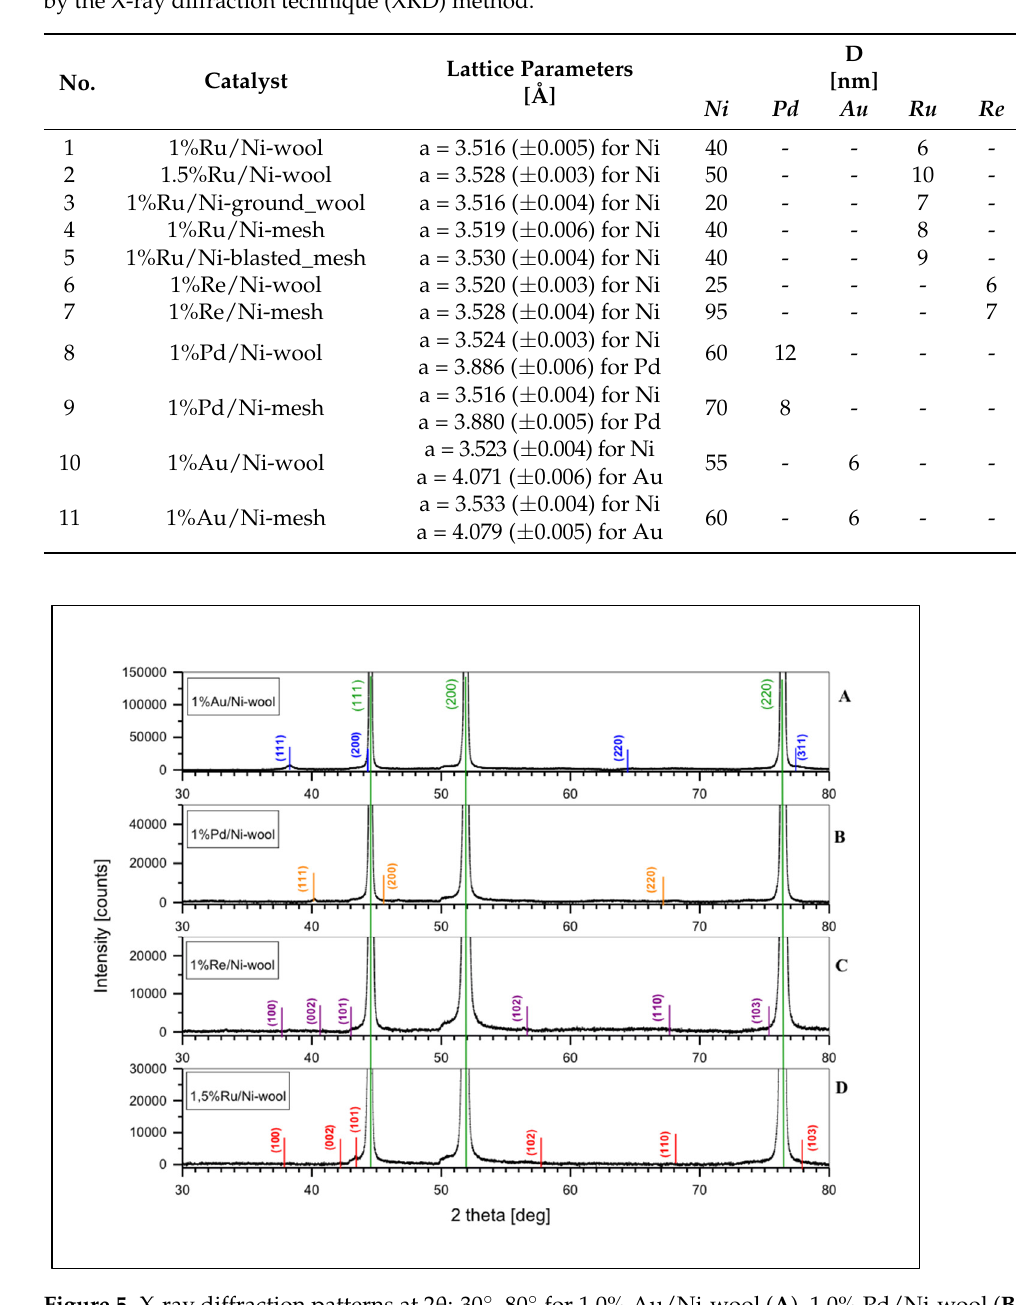
Table 2. The average crystallite size and lattice parameters of the investigated catalysts as determined by the X-ray diffraction technique (XRD) method.